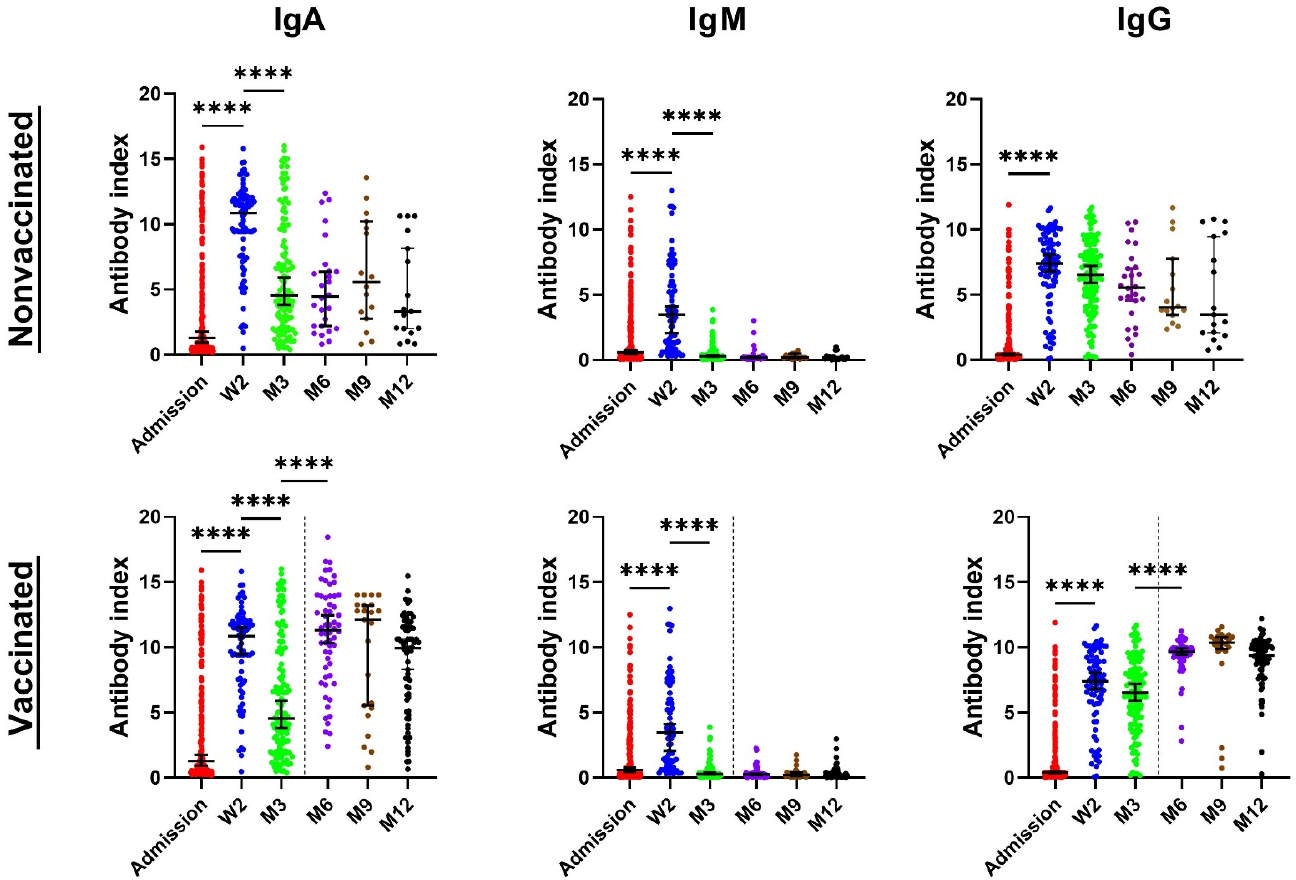
Figure 1. The detected antibody levels in the sera of cohort A over the 12-month period expressed as index values. Data are presented as the median ± 95% confidence intervals. The dotted line indicates the time when some patients started to be vaccinated. The nonparametric ANOVA Kruskal–Wallis post hoc Dunn’s multiple comparisons test was used for statistical evaluation. **** represent statistical significance p < 0.0001. The absence of * marks means no